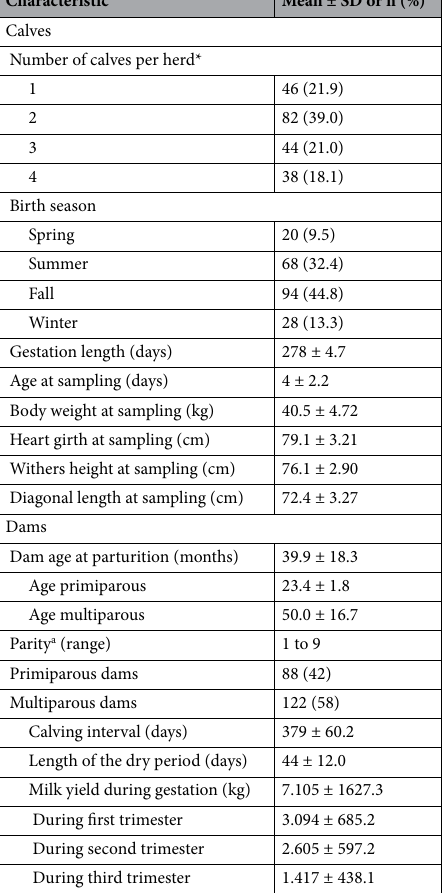
Table 1. Calf and dam characteristics of the studied population. a Parity 1 = after the first parturition. *A detailed distribution of all characteristics across herds is given in Supplementary file